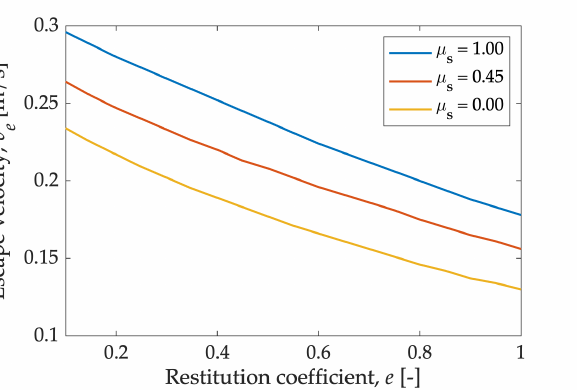
Figure 3. Escape velocity as a function of coefficient of restitution ( e ) and static friction coefficient ( µ s ). Level of cohesion: Bo = 500 with cohesion model SJKR. Rolling friction is